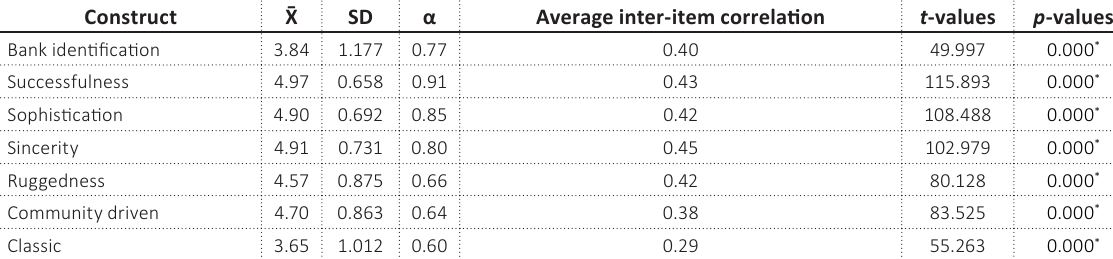
Table 3. SPSS statistics output